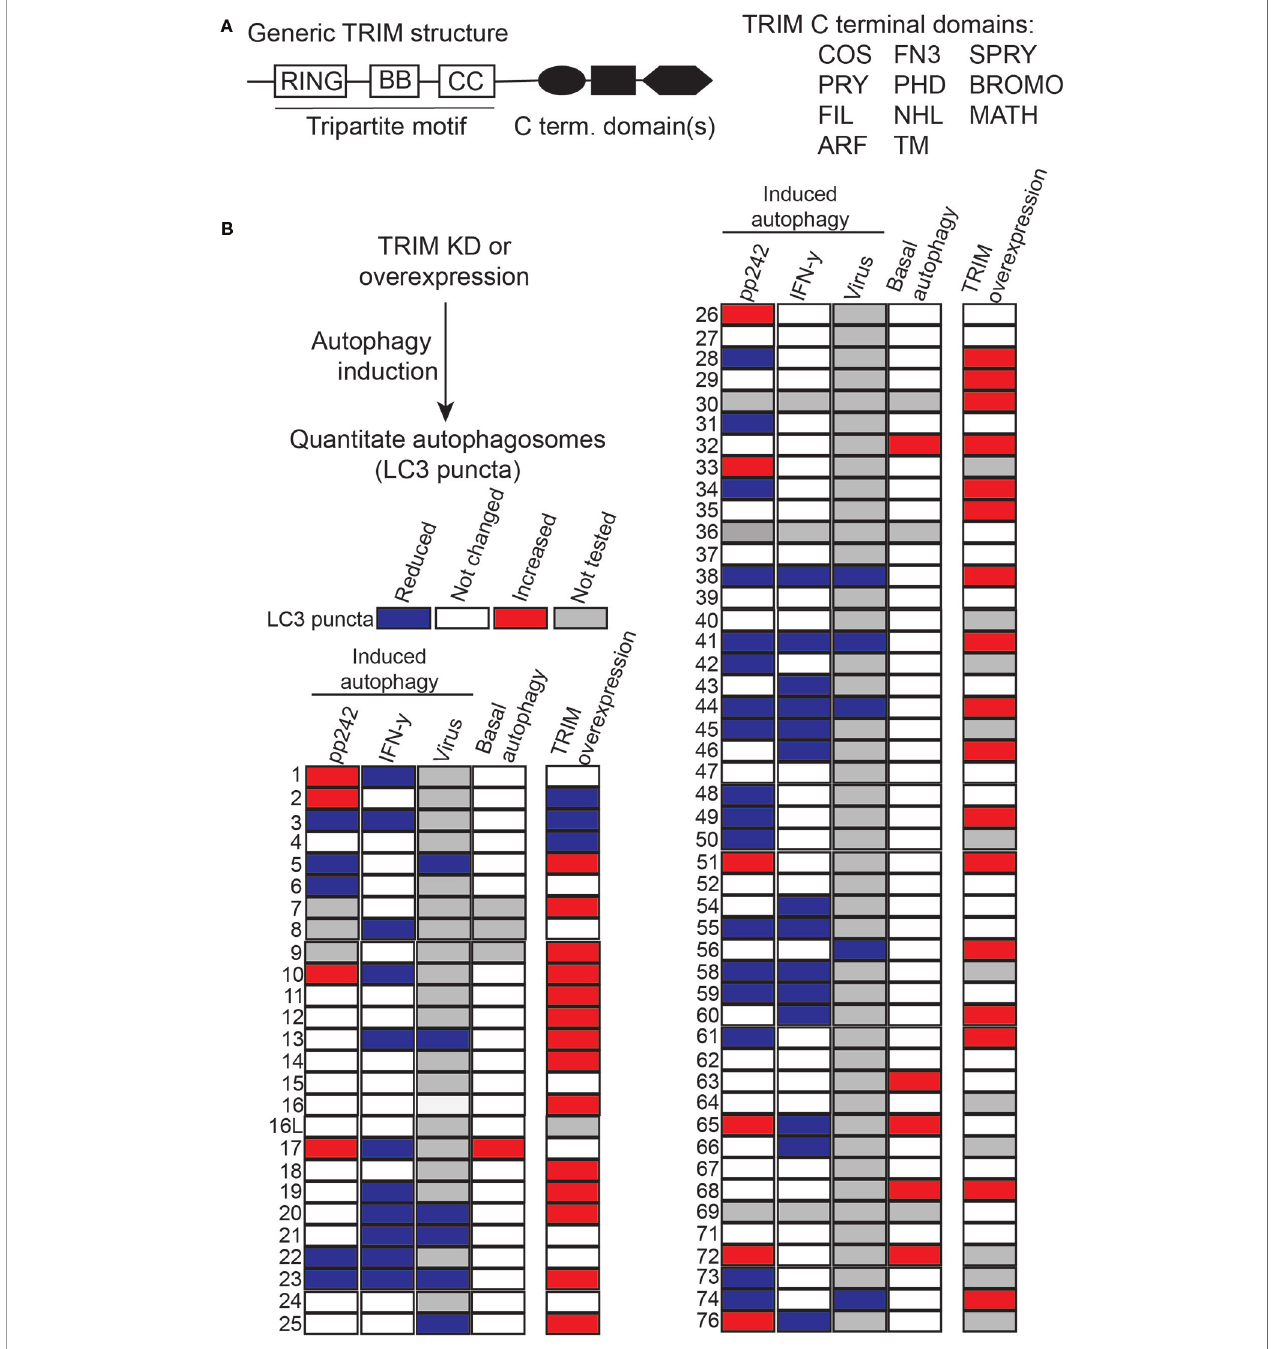
FIGURE 1 | Many tripartite motif-containing protein family members (TRIMs) act as autophagy regulators. (A) Left, schematic of generic TRIM protein domain organization. Typical TRIMs have N-terminal RING domains (RING), one or two B box domains (BB), a coiled-coil (CC) domain and may have one or more C terminal domains. Right, list of C terminal domains present in TRIM family proteins. (B) The results of several previously published TRIM siRNA or over-expression screens are summarized here in heat map format. In all experiments, cells were transfected with TRIM siRNA or expression plasmids and treated or not with a known inducer of autophagy (e.g. pp242) prior to imaging-based quantitation of cytoplasmic LC3B or GFP-LC3B puncta (autophagosomes). TRIMs that signi fi cantly increased or decreased autophagosome abundance relative to negative controls are colored red or blue, respectively. Changes in the abundance of autophagosomes can result from either increased autophagy activation or decreased autophagy fl ux, thus in isolation these data do not indicate mechanisms of individual TRIMs on autophagy but illustrate the broad involvement of TRIMS in autophagy